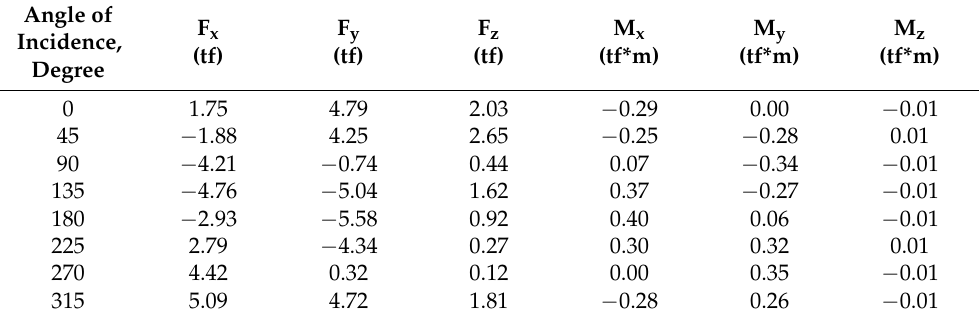
Table 1. ForcesFx, Fy, Fz (tf), bending torques Mx, My, torque Mz (tf*m)for an open model, angle of incidence (degree), Option (0000).